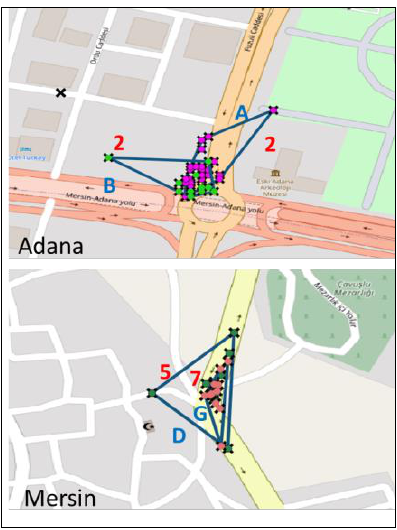
Figure 11. Mersin Region Repeatedly-detected Clusters in Different Periods (2018-2019, 2020-2021) For the periods 2018-2019 and 2020-2021, two regions